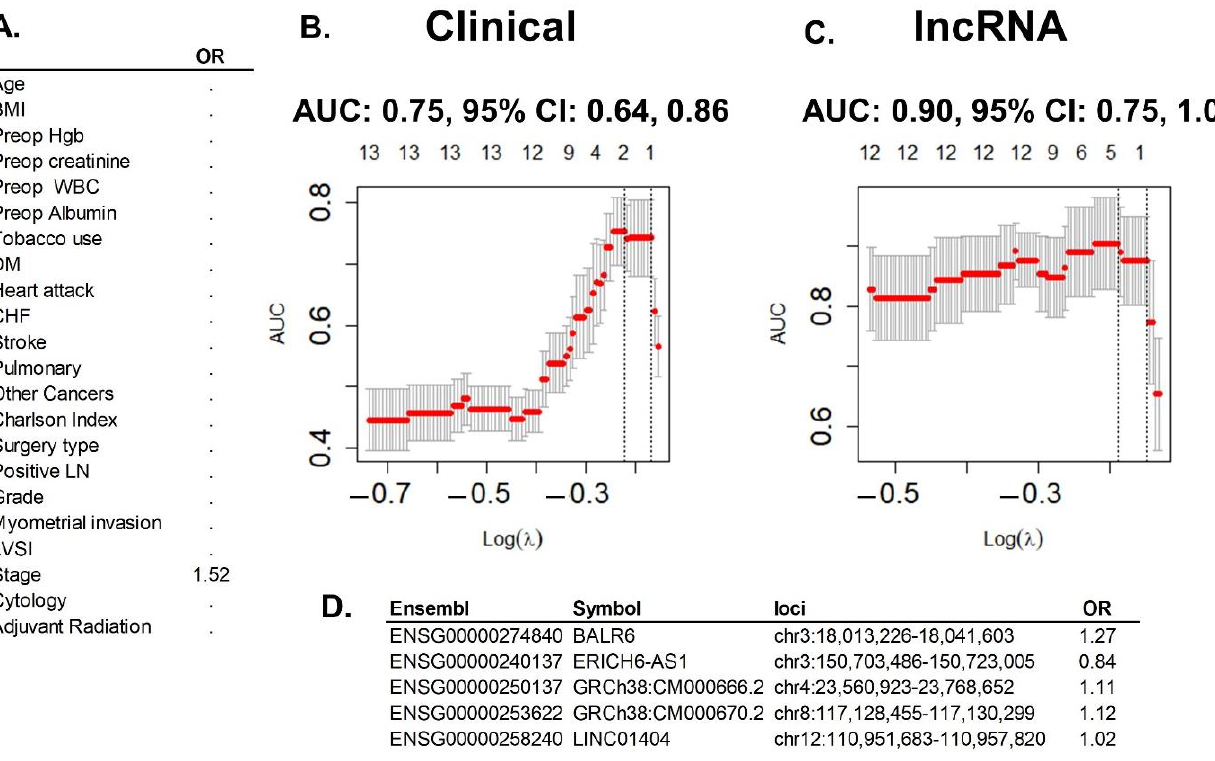
Figure 4. Best prediction model and comparison with clinical model. ( A ) The lasso multivariate regression model with clinical variables: out of the two clinical variables included in the model, only Stage remained as informative for prediction of EEC recurrence after the analysis, with an increased risk for recurrence as stage increases. ( B ) Graphic representation of the clinical lasso analysis: superior margin reflects number of variables; left margin reflects performance of the model measured in AUC (area under the curve); lower margin reflects lambda tunning parameter chose by cross-validation to optimize the model. The optimized AUC was 0.75 (95% CI: 0.68, 0.86), between the dotted lines. ( C ) Graphic representation of the lncRNA data lasso analysis (same margins and design as before): optimized AUC of 0.9 (95% CI: 0.75, 1.00). ( D ) The lasso multivariate regression model with lncRNA data: out of the 544 clinical variables included in the model, five single lncRNAs remained as informative for prediction of EEC recurrence. Four of them increased risk (OR > 1) and one protected from recurrence (OR < 1). Graphics were generated with R package